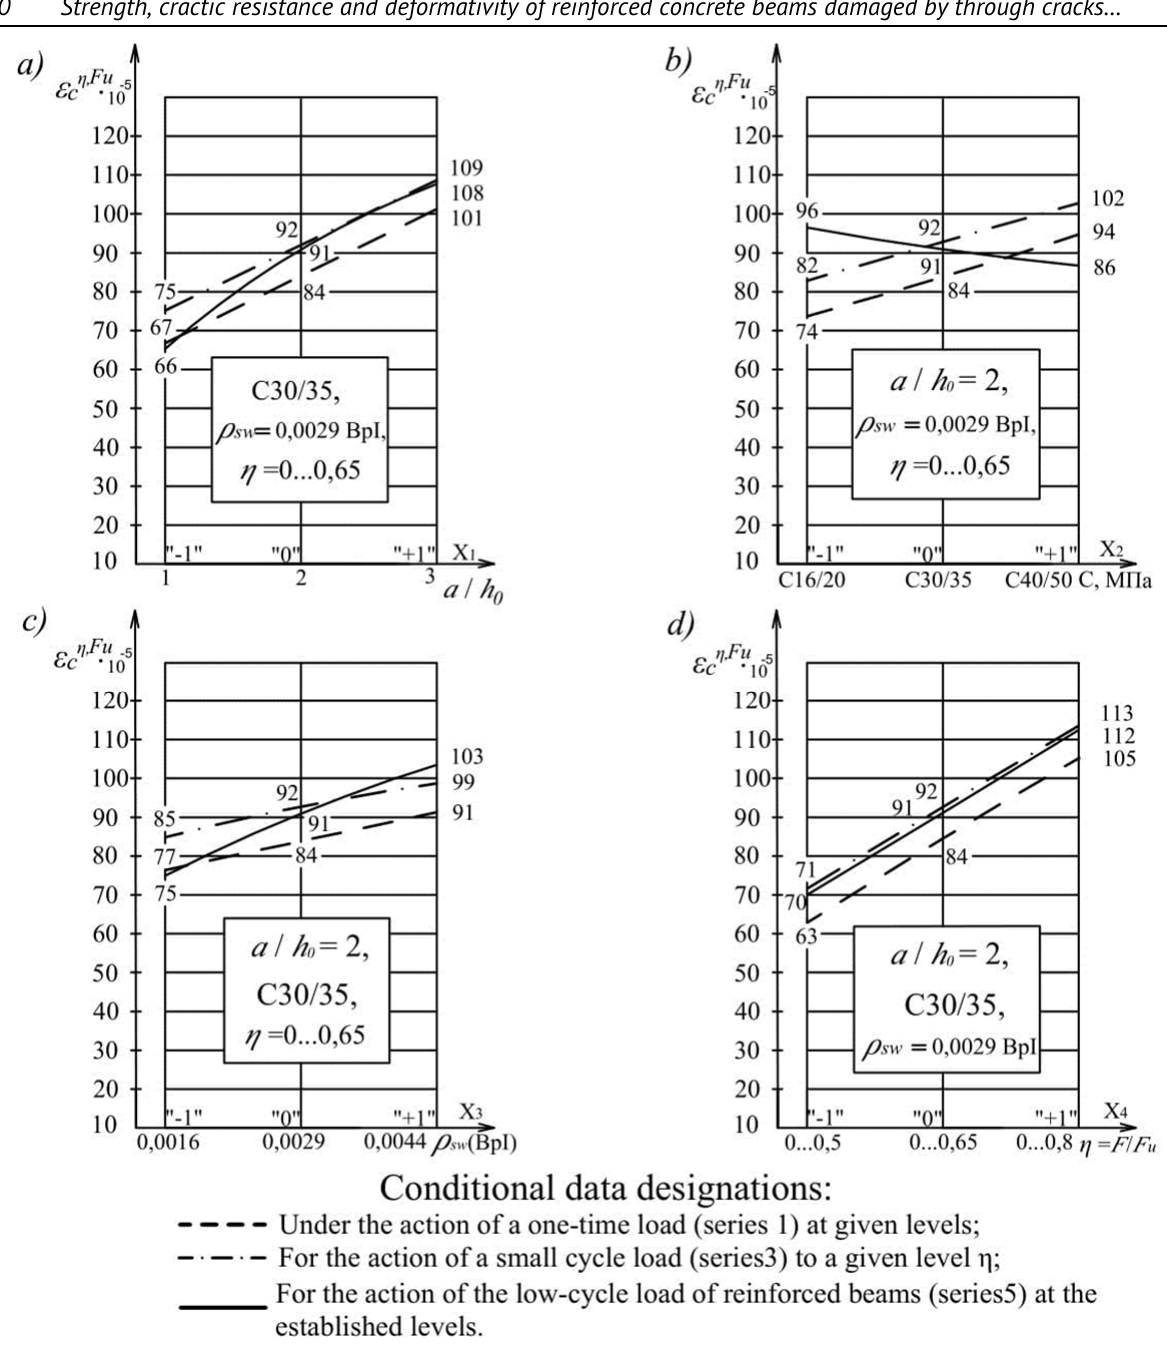
Figure 4. Relative deformations of the compressed concrete in the tested beam samples vs ( а ), concrete grade С (b), quantity of the transverse the value of the relative shear span, а /h 0 reinforcement ρ (c) and level of the low-cycle repeated loading ɳ sw